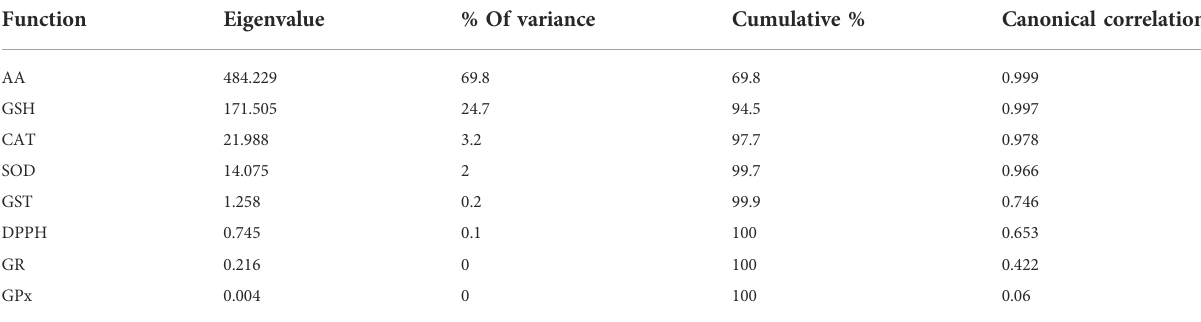
TABLE 4 Discriminant function analysis of data obtained for oxidative stress physiology parameters in Scylla serrata with respect to spatio-temporal variation.